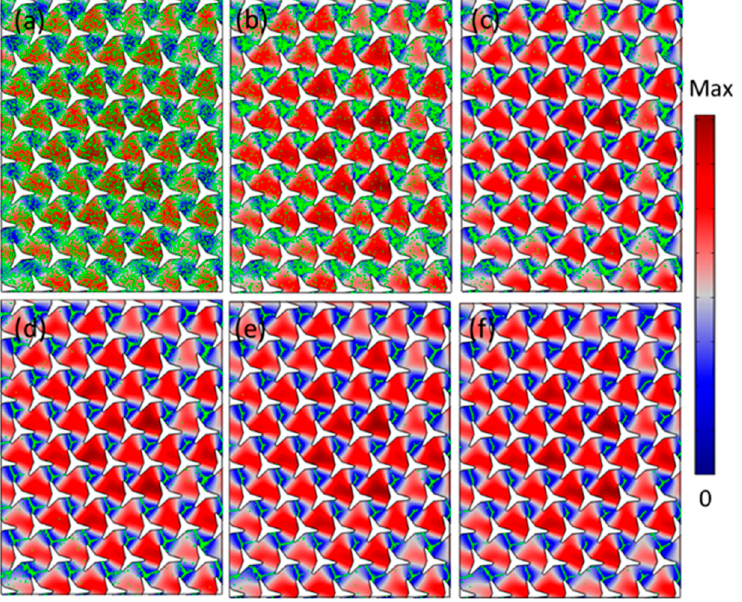
Figure 3. Numerical validation of the microparticles patterning and locations when the incident wave was excited at the frequency of 66.9 kHz. ( a – f ) The microparticles distribution at the stating positions when (cid:1872) = 0 s, (cid:1872) = 1 s, (cid:1872) = 2 s, (cid:1872) = 3 s, (cid:1872) = 4 s, and (cid:1872) = 5 s. other vortex/Dirac point with the frequency at 167.6 kHz, as shown in Figure 4. It is the particle distribution and locations when (cid:1872) = 0 , (cid:1872) = 1 , (cid:1872) = 2 , (cid:1872) = 3 , (cid:1872) = 5, and (cid:1872) = 8 s.